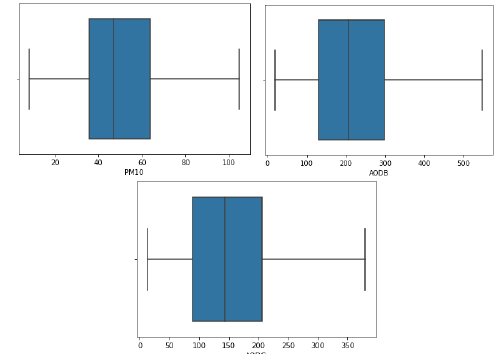
Figure 7. Box plots of the input parameters for PM 10 models.